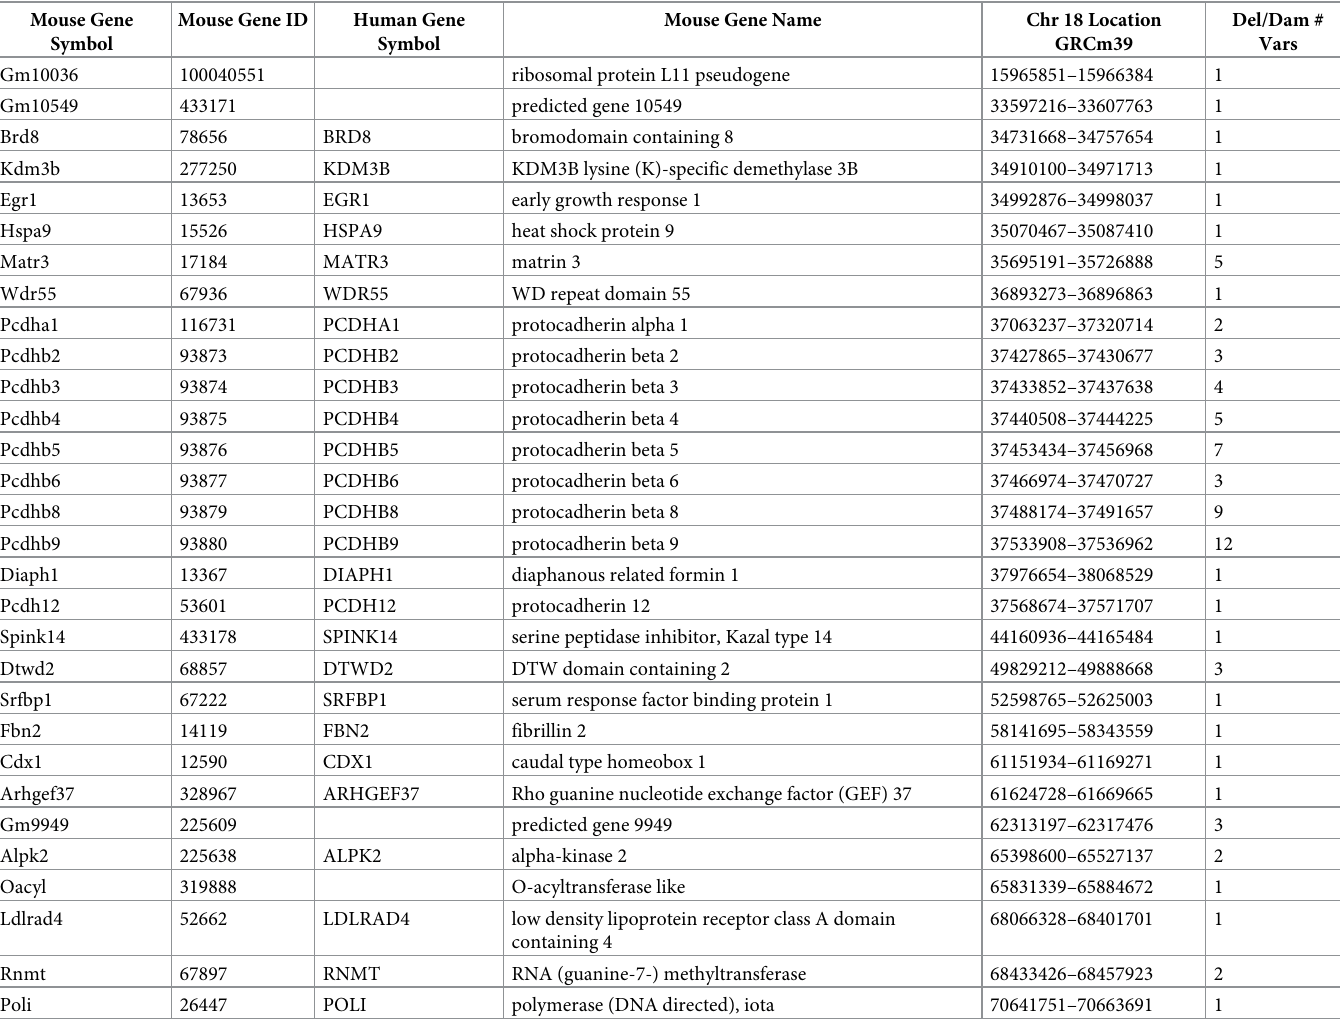
Table 6. Protein coding genes in the Chr18 QTL of G59S-hDCTN1 mice demonstrating non-synonymous variations deemed to be deleterious and/or damaging. Mouse Gene Mouse Gene Symbol